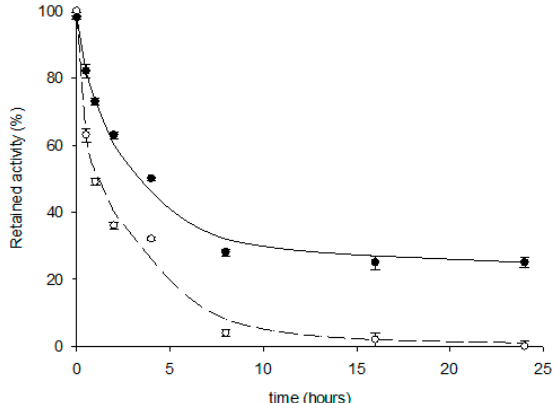
Figure 4. Thermal inactivation profile of M Lm PDT3/M Ec HPRT3 on cladribine synthesis at 40 ◦ C ( • ) and 50 ◦ C ( ○ ).